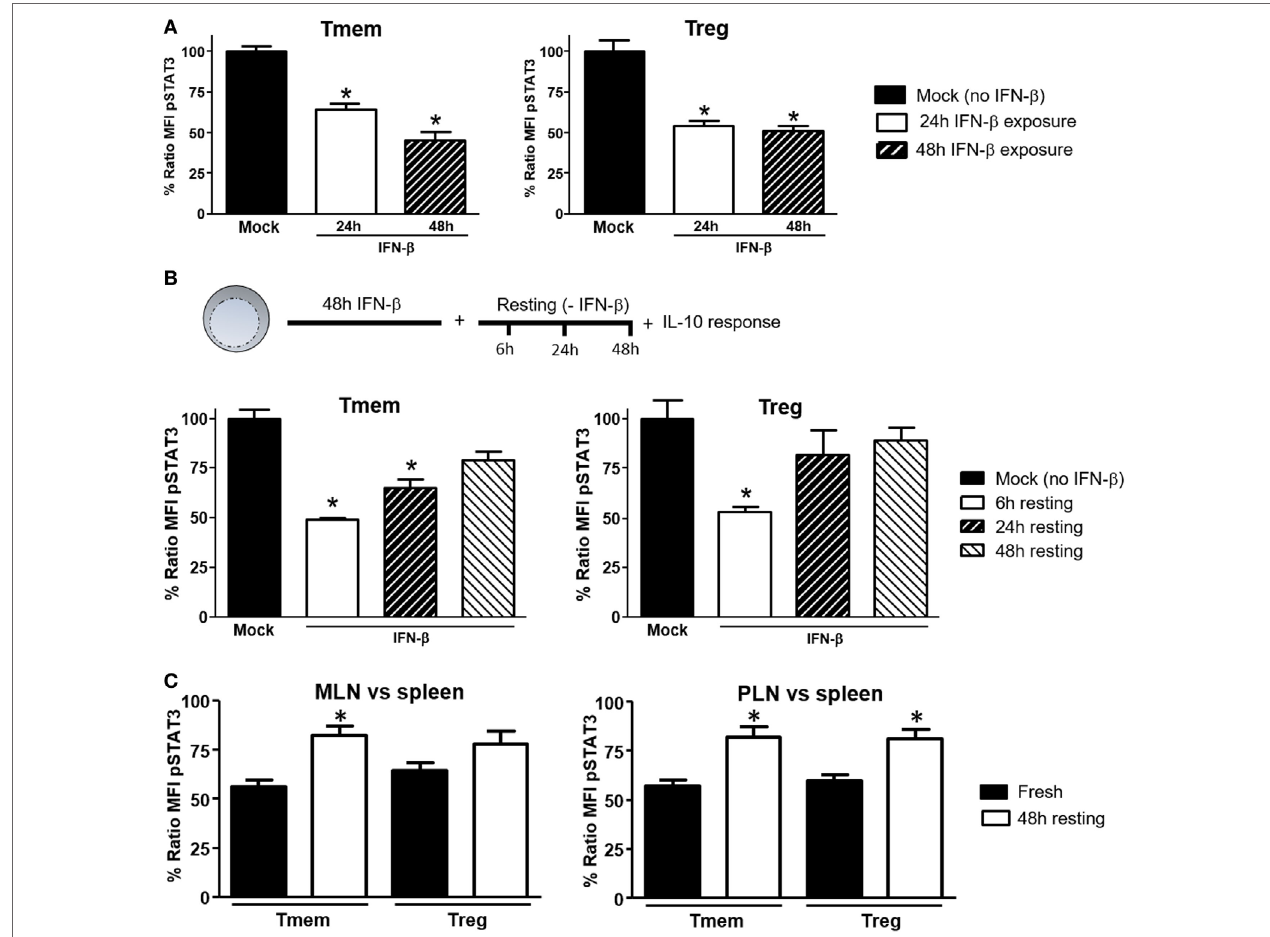
FigUre 4 | Induction of interleukin-10 (IL-10) signaling inhibition in T cells requires prolonged exposure to IFN- β but is reversible. (a) Purified T cells from C57BL/6 mice were cultured for 24 or 48 h with or without IFN- β (5 ng/ml) and rested in cytokine-free media for six additional hours. Cells were then left untreated or stimulated with IL-10 (40 ng/ml) and the inhibition of P-STAT3 induction by IL-10 assessed as indicated in Figure 1 . (B) Purified T cells from C57BL/6 mice were cultured for 48 h with or without IFN- β (5 ng/ml) and then rested in cytokine-free media for the indicated time (6, 24, and 48 h). The levels of P-STAT3 in response to IL-10 (40 ng/ml) were then assessed as previously indicated. The ratio mean fluorescence intensity (MFI) (a,B) was calculated comparing the coefficient index of P-STAT3 after IL-10 stimulation between IFN- β exposed and mock, considering levels in mock cells as 100% of expression. Data of n = 4 individual experiments are shown and expressed as % of ratio MFI ± SEM, * p < 0.05, Mann–Whitney U test. (c) . Cells from pancreatic lymph nodes (PLN), mesentheric lymph nodes (MLN), and spleens of 4- to 6-week-old nonobese diabetic (NOD) mice were either freshly stimulated or cultured in cytokine-free media for 48 h and then stimulated with IL-10 (40 ng/ml) for 20 min. The levels of P-STAT3 in response to IL-10 (40 ng/ml) were then assessed as previously indicated. Cumulative results are shown in the graph where bars represent the normalized P-STAT3 MFI ratio in memory T cells (Tmem) or regulatory T cell (Treg) after IL-10 stimulation between the spleen and PLN or MLN in fresh vs rested conditions. Ratio MFI was calculated by comparing the coefficient index of P-STAT3 between the two different organs, considering the levels in spleen as 100% of expression. Data of n = 4 mice per group are shown and expressed as % of ratio MFI ± SEM, * p < 0.05, Mann–Whitney U